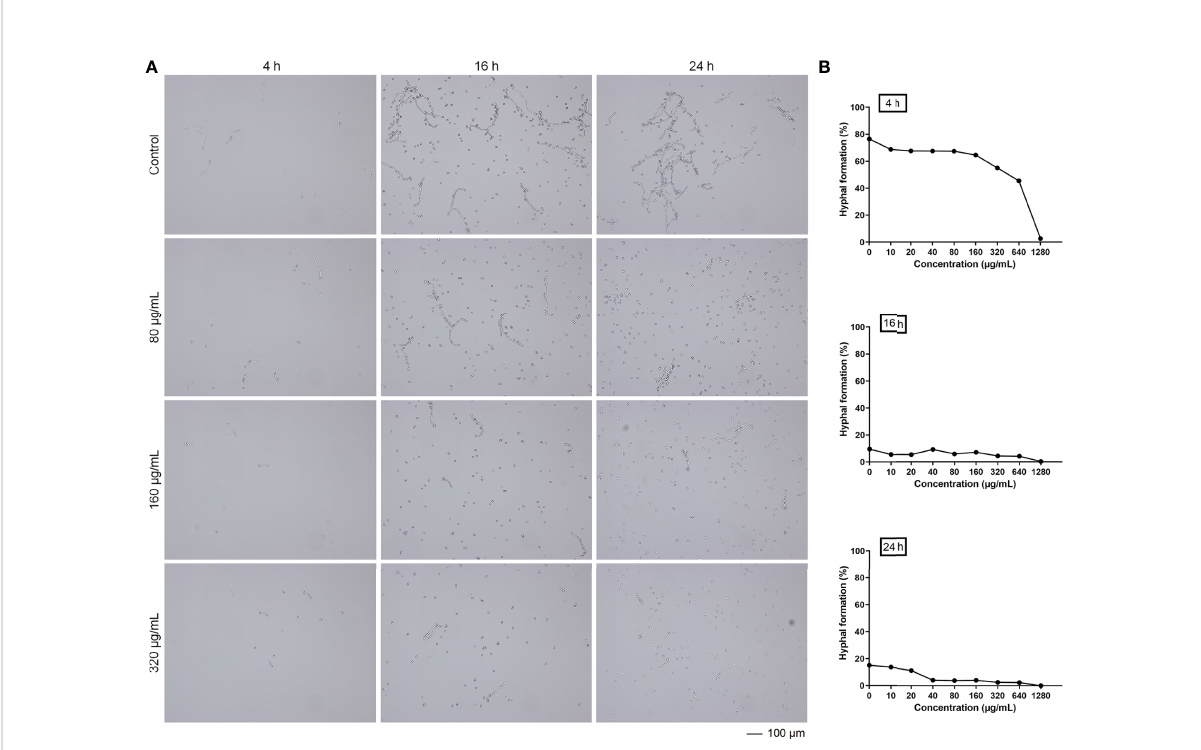
the cytoplasmic contents underwent crumpling, abnormal distribution, and even leaked out. In addition, the CFW staining and the fl uorescence quanti fi cation results showed that magnolol could exert antifungal activity by inducing C. albicans cell wall stress and defects in a concentration-dependent manner ( P < 0.001) (Figure 4B, C). When magnolol ’ s